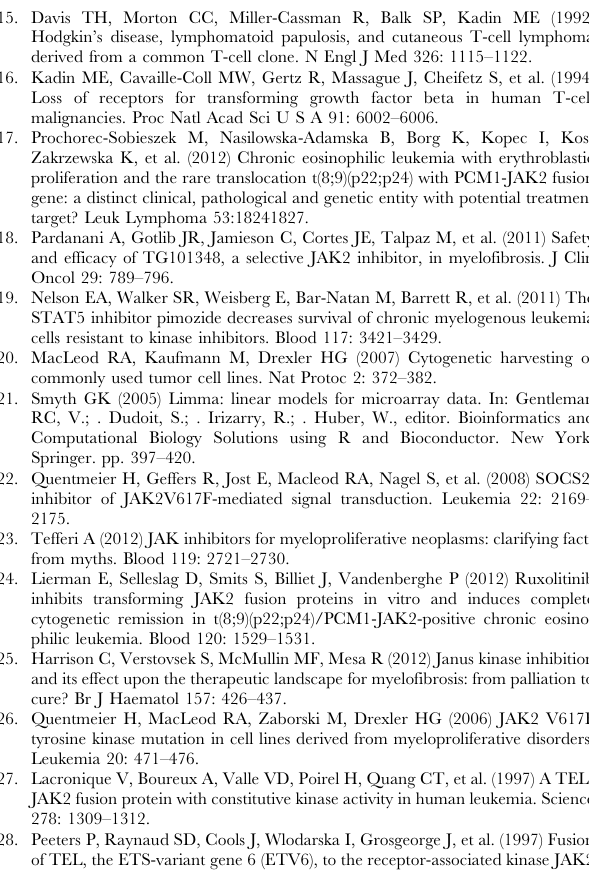
Table S2 Ontology profiling of genes downregulated in MAC- the Materials and Methods. Shows ontology profiling using the Gene Set Enrichment (GSEA) engine hosted by the Broad Table S3 Top upregulated (A) and downregulated (B) genes in MAC-1/2A/2B cells. Shows 400 genes most conspicuously expressed when compared to control T-ALL and CTCL cell lines listed in the Materials and